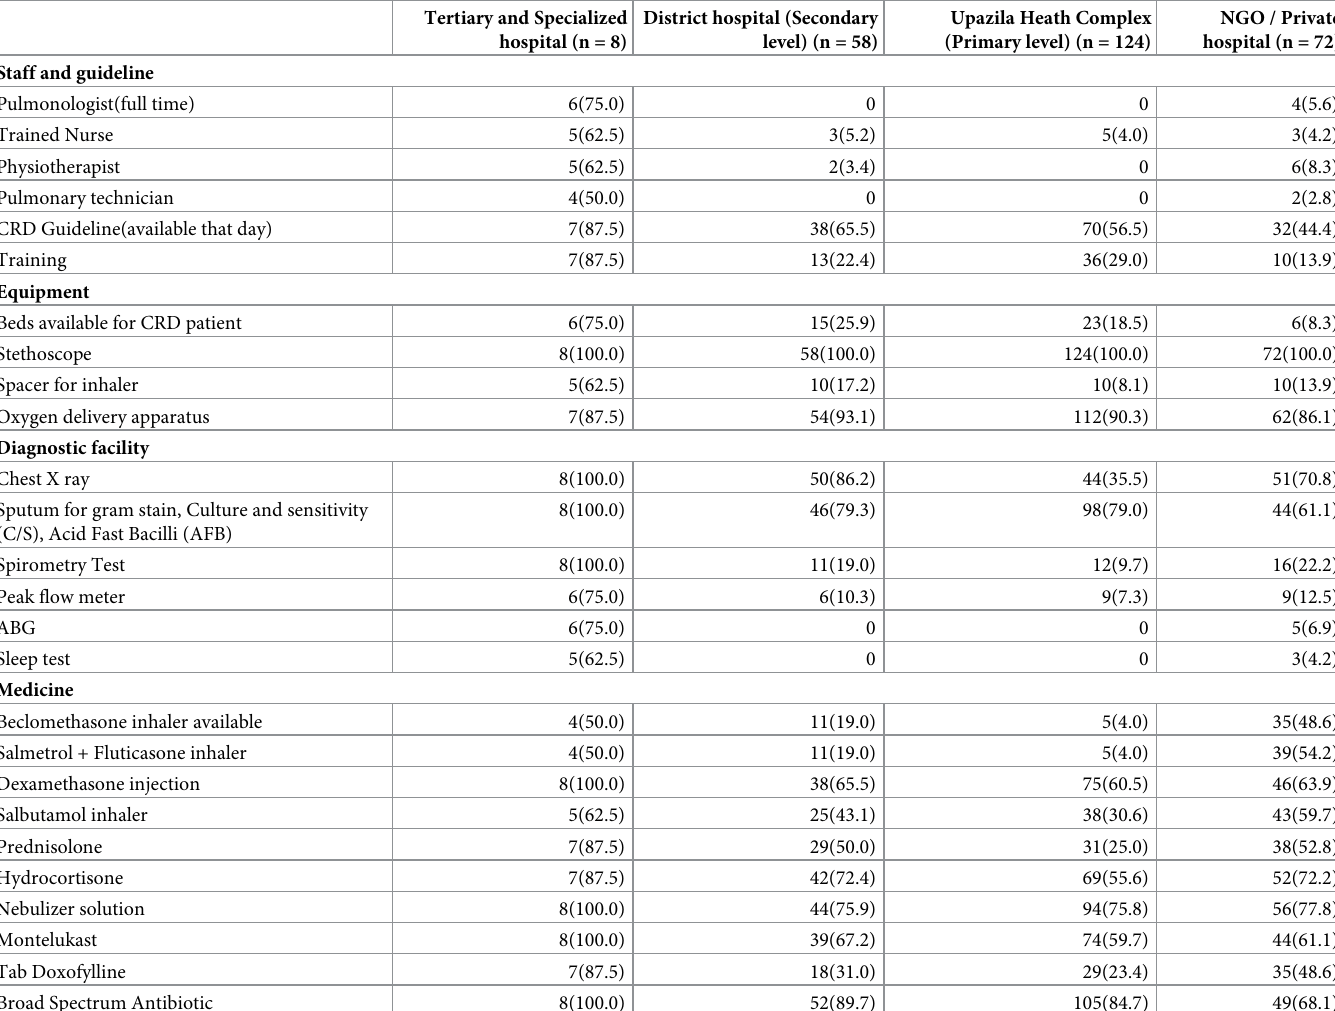
Table 3. Mean availability of CRD service readiness indicators in different levels of facilities (n =